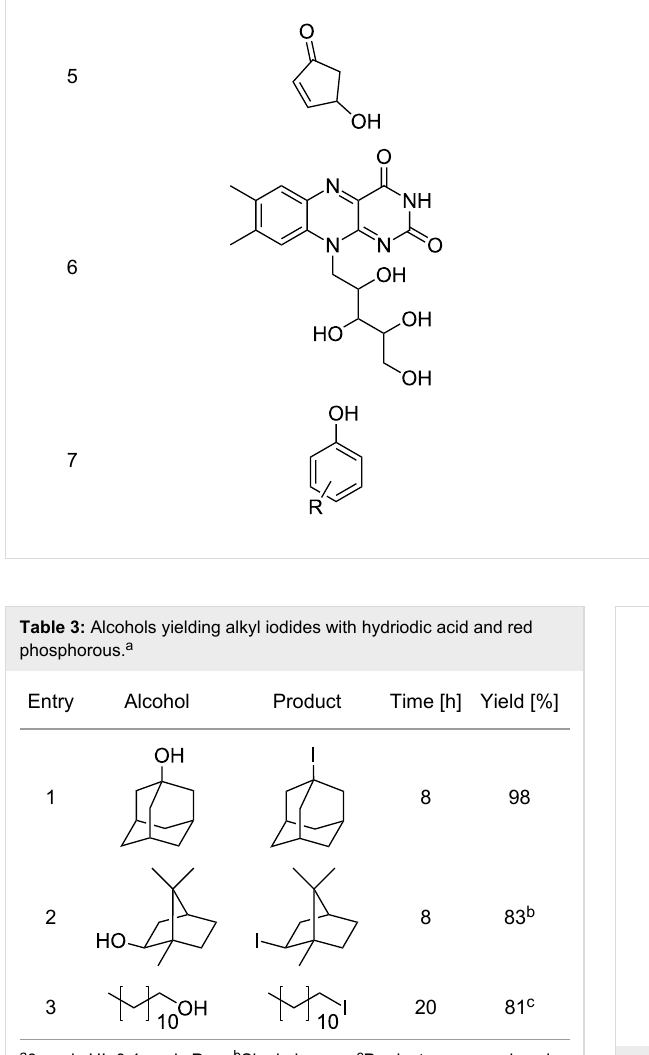
Scheme 1: Mechanism of the alcohol reduction and recycling of